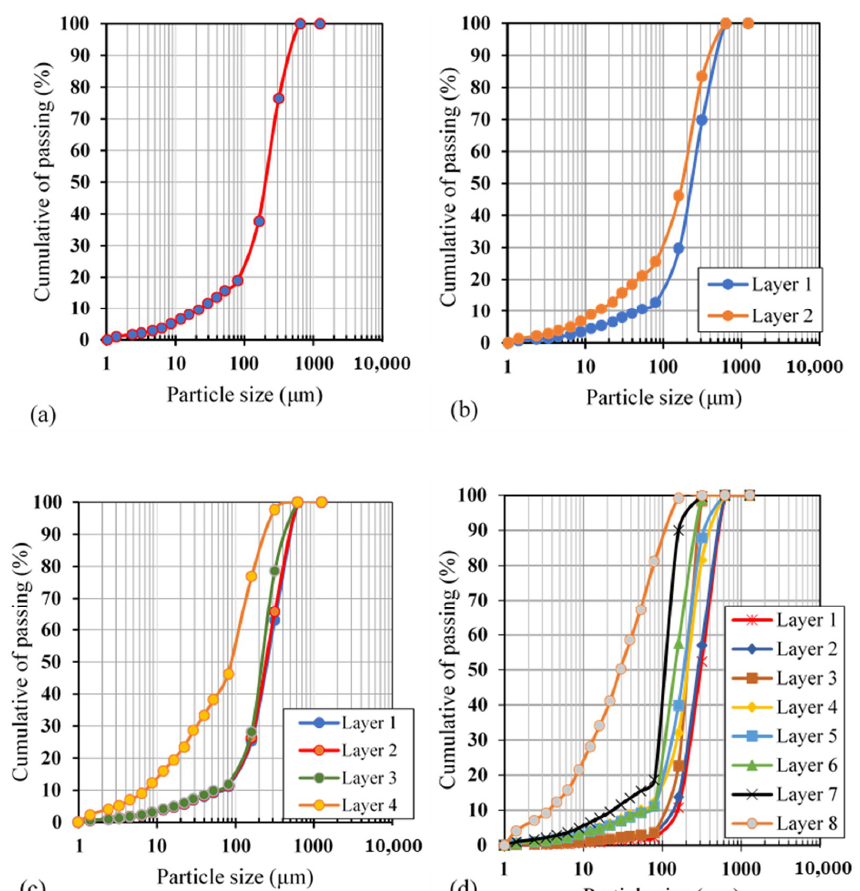
Figure 5. Particle size distributions of different layers of cemented hydraulic fill (CHF) after settlement and curing: ( a ) 10 cm; ( b ) (20 cm); ( c ) 40 cm; ( d ) 80 cm (Layers 1 to 8 indicate the locations of the layers from the base to the top of a backfilled column).